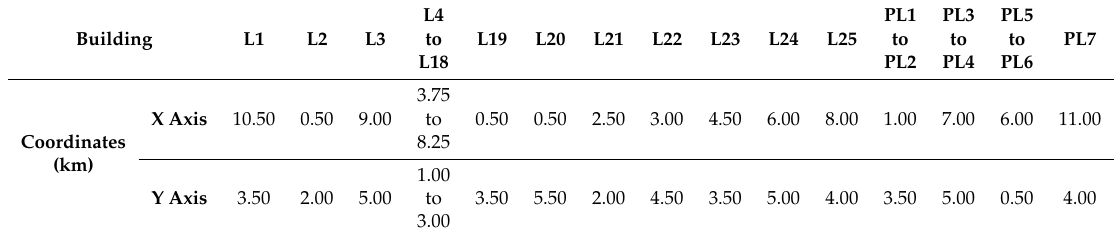
Table 3. Building coordinates on the xy